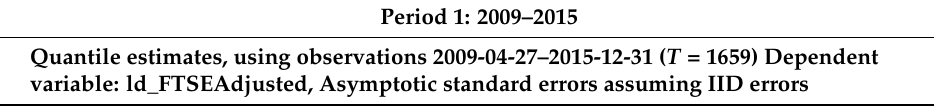
Table 7. Quantile regression results of regression of FTSE on